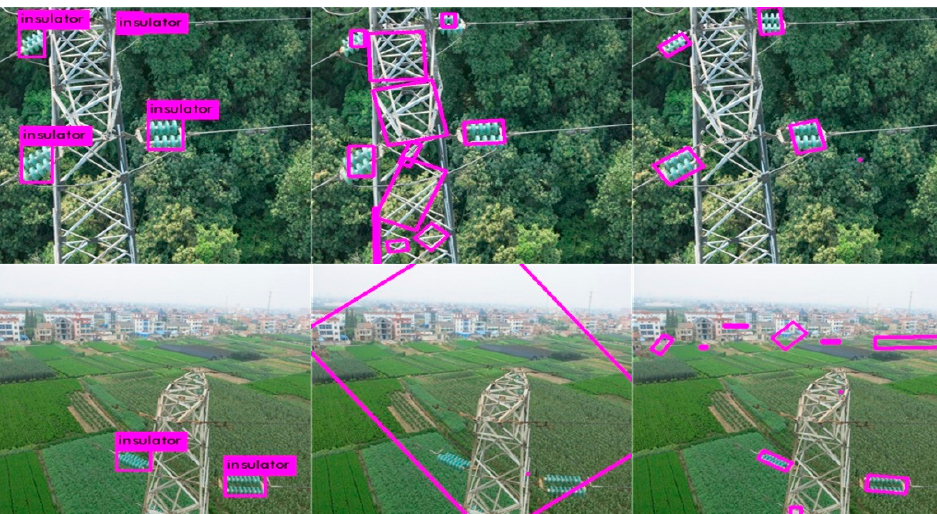
Figure 6. Experiments in different aerial scenes. First row: sky. Second row: mountain. Third row: building and road. Fourth row: forest. Fifth row: farmland. First column shows the performances of our proposed method, while the second column and the third column exhibit the performances of method [20] and method [11], respectively. The labels in results of the proposed method are marked with the word ‘Insulator’, please zoom in for a better view. Based on the observation of Figure 6, it can be seen the proposed method can accurately detect the insulators in different aerial scenes.